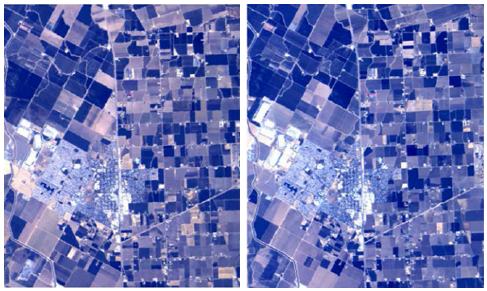
Figure 4. RGB rendering of the Bay Area dataset scenes.